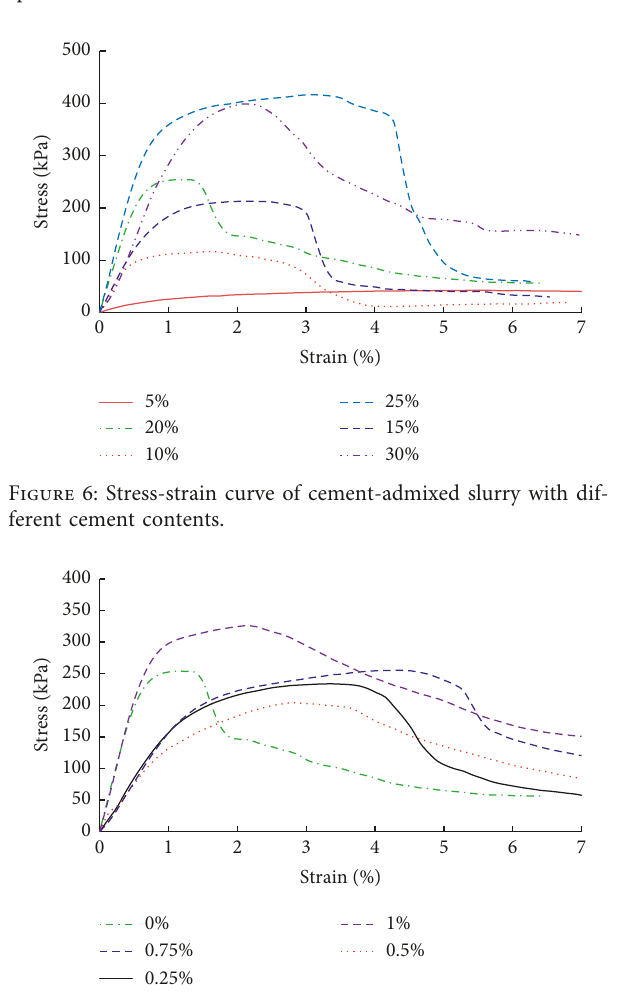
Figure 7: Stress-strain curve of cement and fiber admixed slurry with a cement content of 20% and different fiber contents.